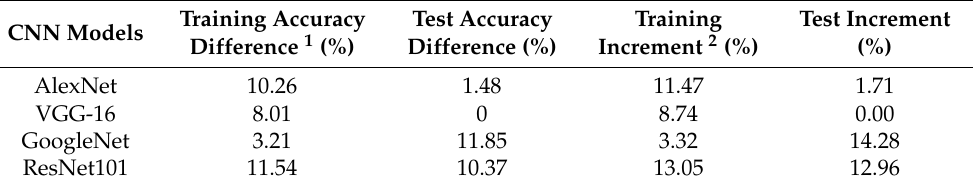
Table 2. Impact on model accuracy before and after using transfer